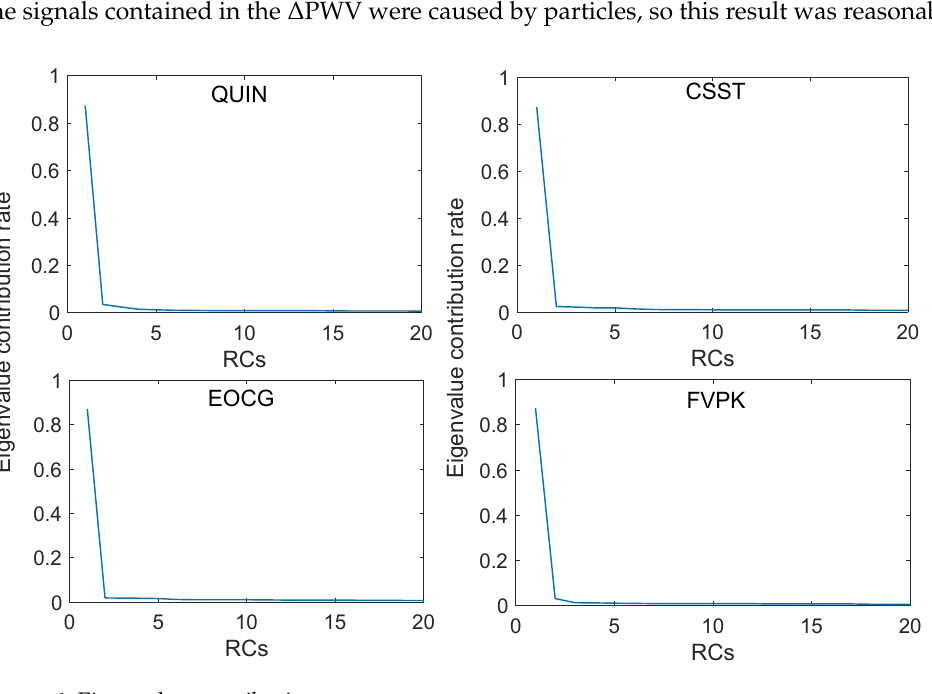
Table 7. Correlation comparison between PM10 data and ∆ PWV before and after reconstruction. GNSS